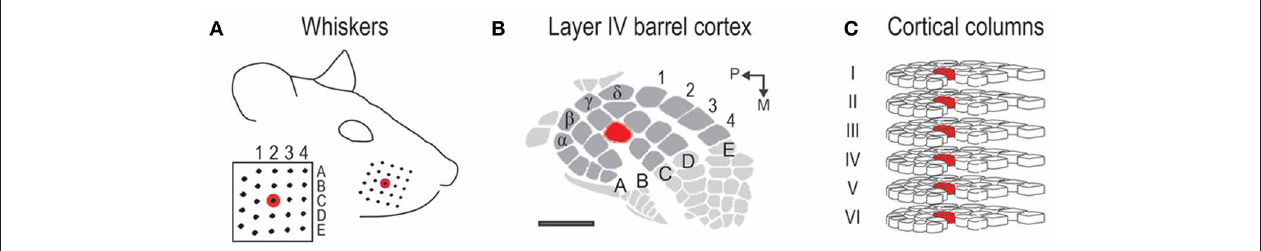
FIGURE 1 | Rat whisker-to-barrel system. (A) The 24 largest whiskers located in rows A–E and arcs 1–4 plus the 4 Greek whiskers. Red = central whisker C2. (B) Barrel cortex subregion of layer IV primary somatosensory cortex. Anatomical representations (barrels) for the 24